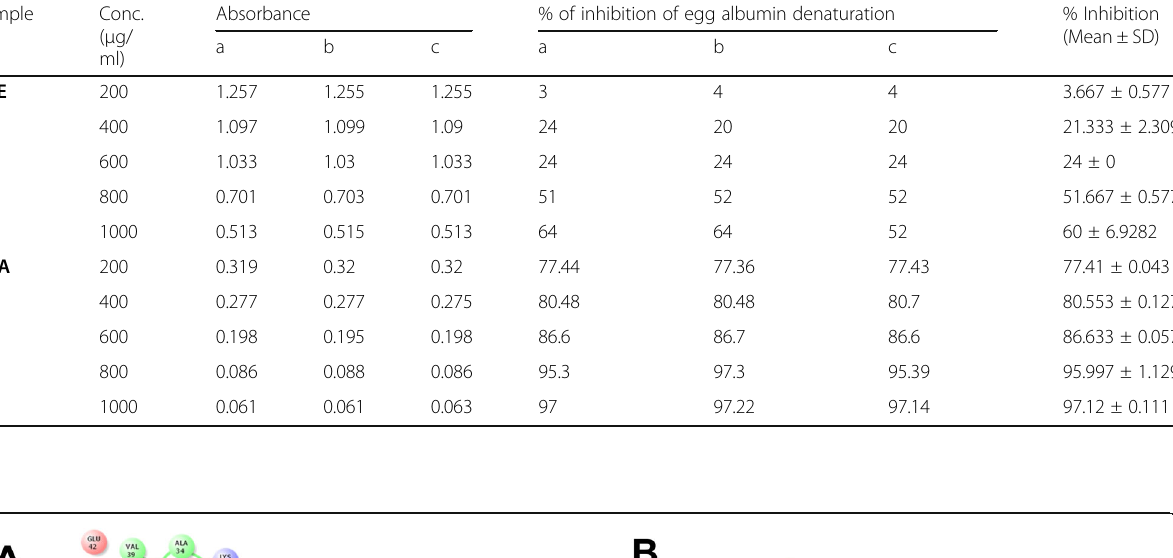
Table 3 Effect of CEE and ASA on egg albumin denaturation Sample